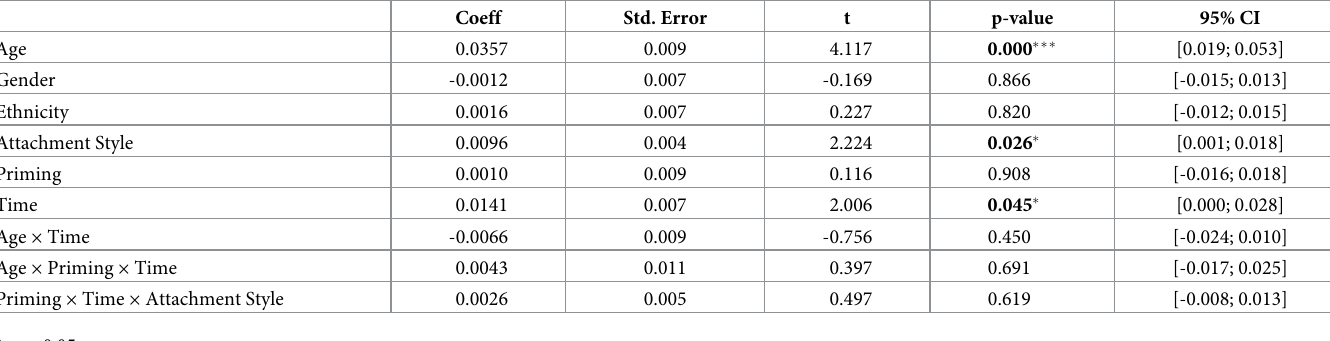
Table 2. Selected effects and interactions of the Multiple Linear Regression results’ table.